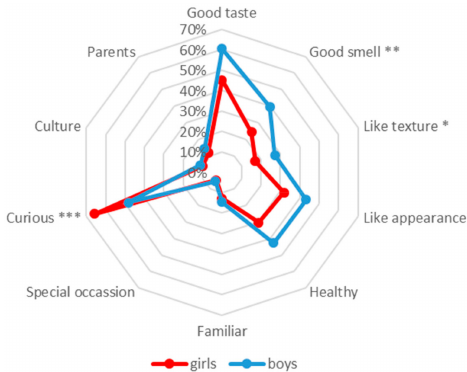
Figure 2. Reasons for accepting the food stimuli for girls and boys (pumpkin n = 79 / 80; kale n = 94 / 100; seaweed n = 92 / 89; physalis n = 93 / 94; caviar n = 86 / 80; herring n = 69 / 72; anchovy n = 53 / 66; blue cheese n = 69 / 62; deer salami n = 89 / 94); n = number of girls / boys accepting a food stimulus; the particular frequencies correspond to the lines below them and 0% corresponds to the center of the spider chart. Level of significance: * p ≤ 0.05, ** p ≤ 0.01, *** p ≤ 0.001.